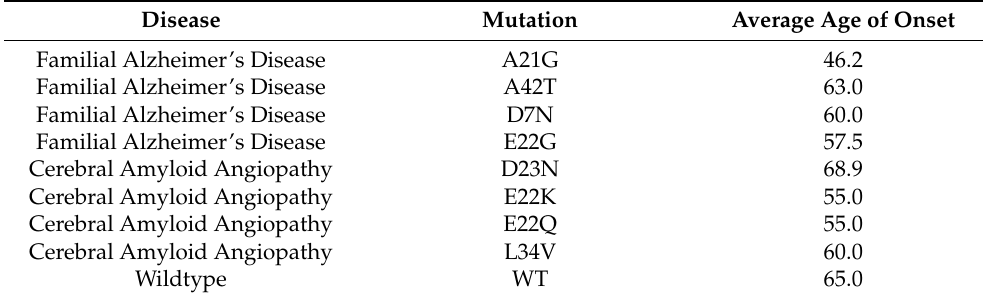
Table 6. Average Age of Onset.